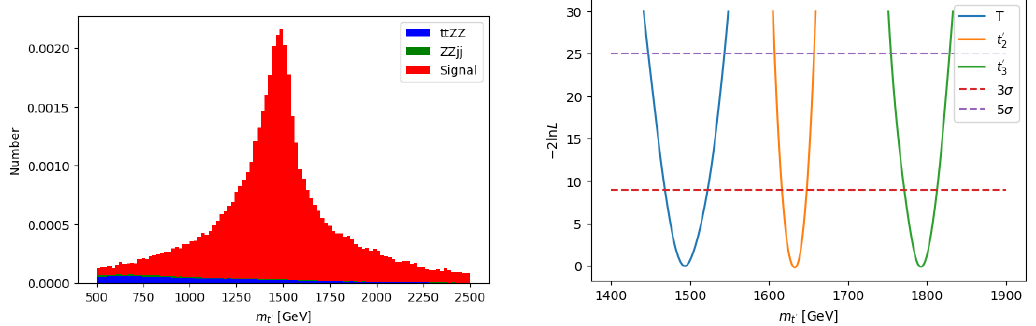
Figure 3 . Left panel: reconstructed invariant mass m ( ‘ + ‘ (cid:0) j ) for signal (LH model) and principal backgrounds, in the 4 ‘ +2 j channel, after cuts described in the text. Right panel: likelihood pro(cid:12)le for the masses of top partners T (LH model) and t 0 reconstructed Zt decay in the 4 ‘ + 2 j (cid:12)nal state.